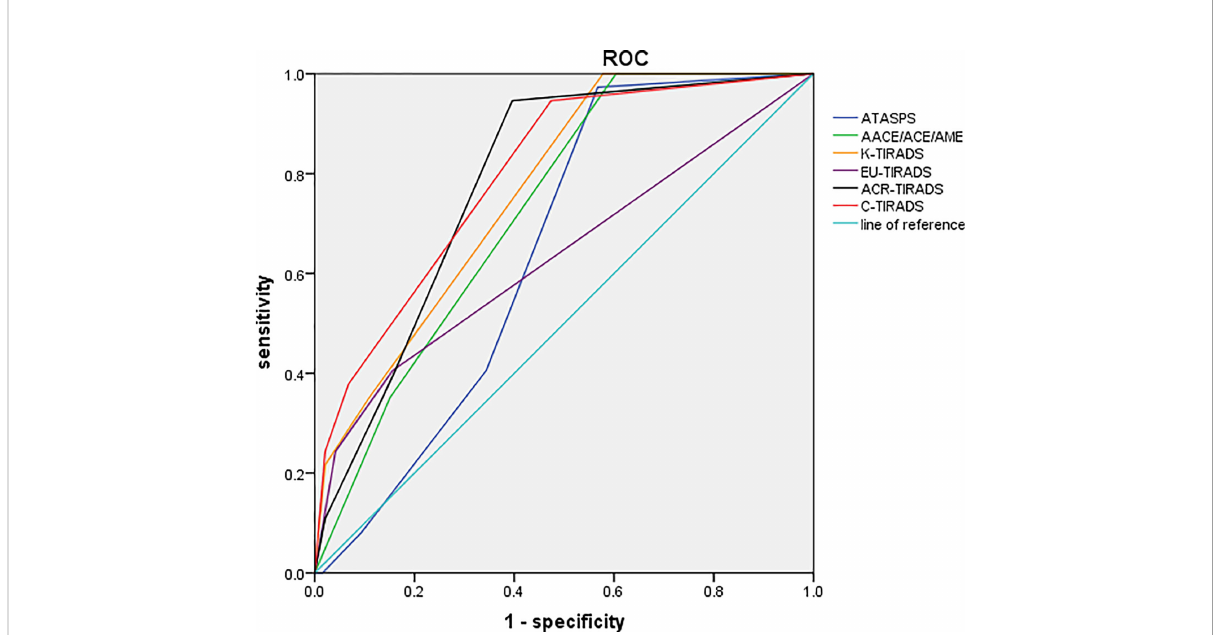
FIGURE 3 ROC curves of the six ultrasound-based risk strati fi cation systems for distinguishing FTA from FTC. ROC, receiver operating characteristic; FTA, follicular thyroid adenoma; FTC, follicular thyroid carcinoma; ATASPS, The American Thyroid Association Sonographic Pattern System; AACE/ ACE/AME, American Association of Clinical Endocrinologists, American College of Endocrinology, and Associazione Medici Endocrinology; K- TIRADS, Korean thyroid imaging reporting and data system; EU-TIRADS, European Thyroid Association for the imaging reporting and data